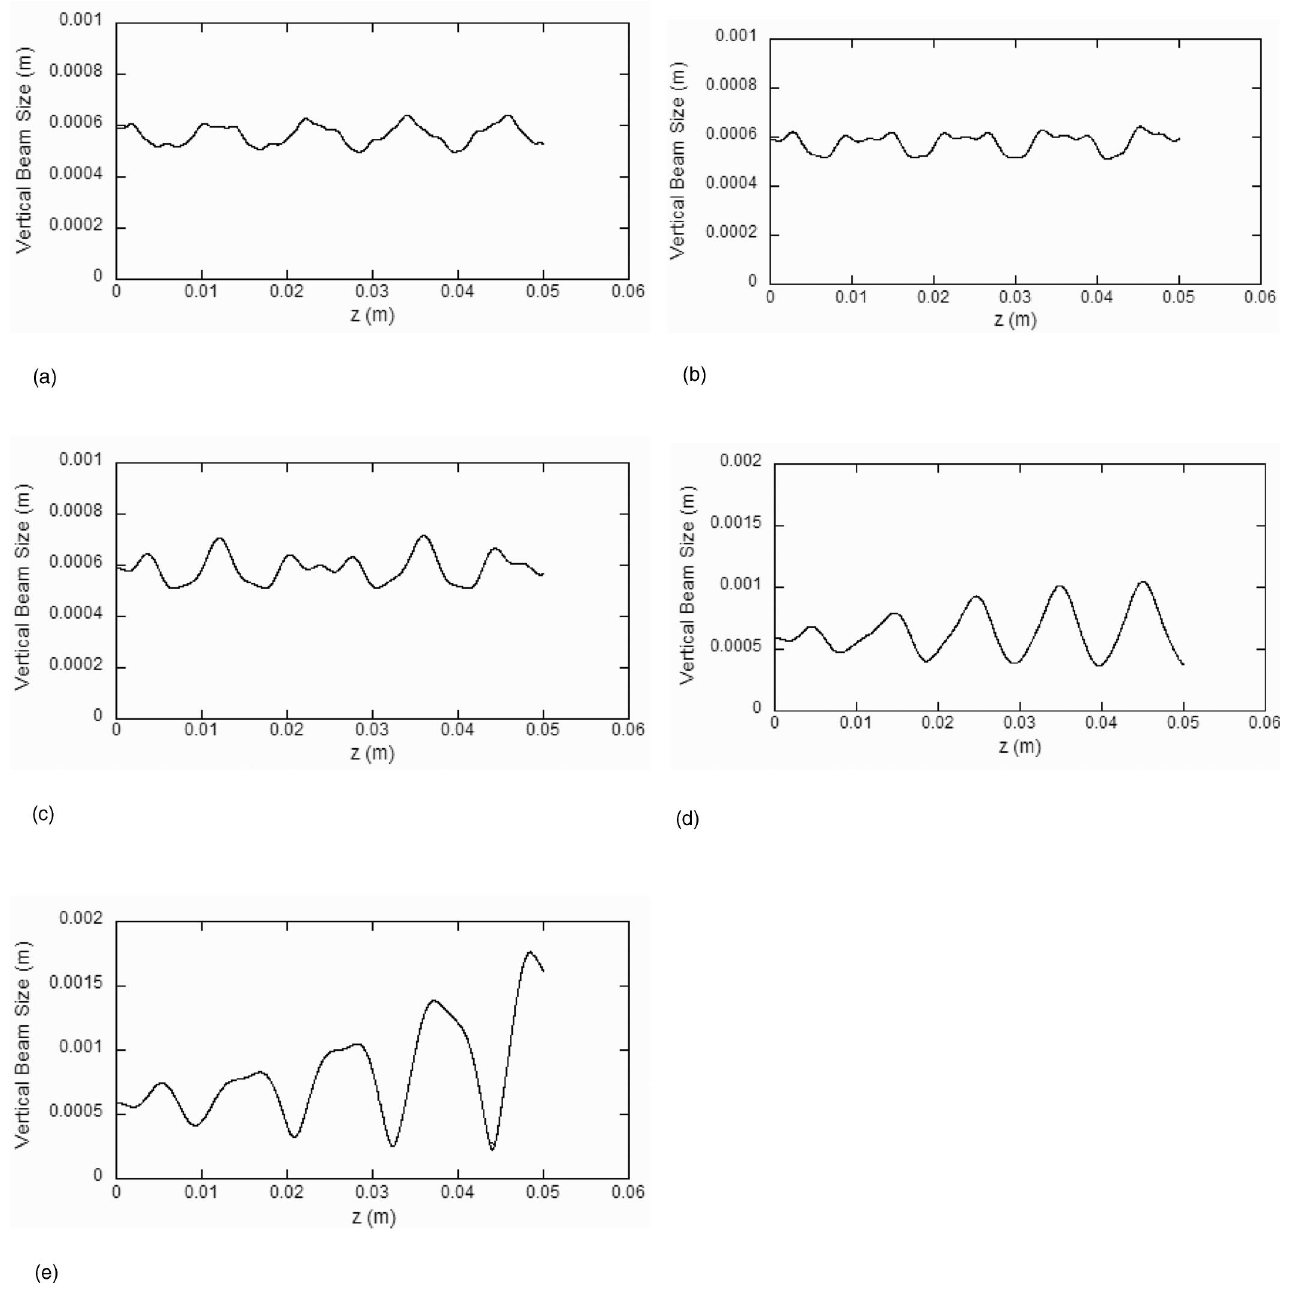
FIG. 14. Vertical beam size for PPM focusing augmented by periodic quadrupole (a) 4-mm period, (b) 6-mm period, (c) 8-mm period, (d) 10-mm period, and (e) 12-mm